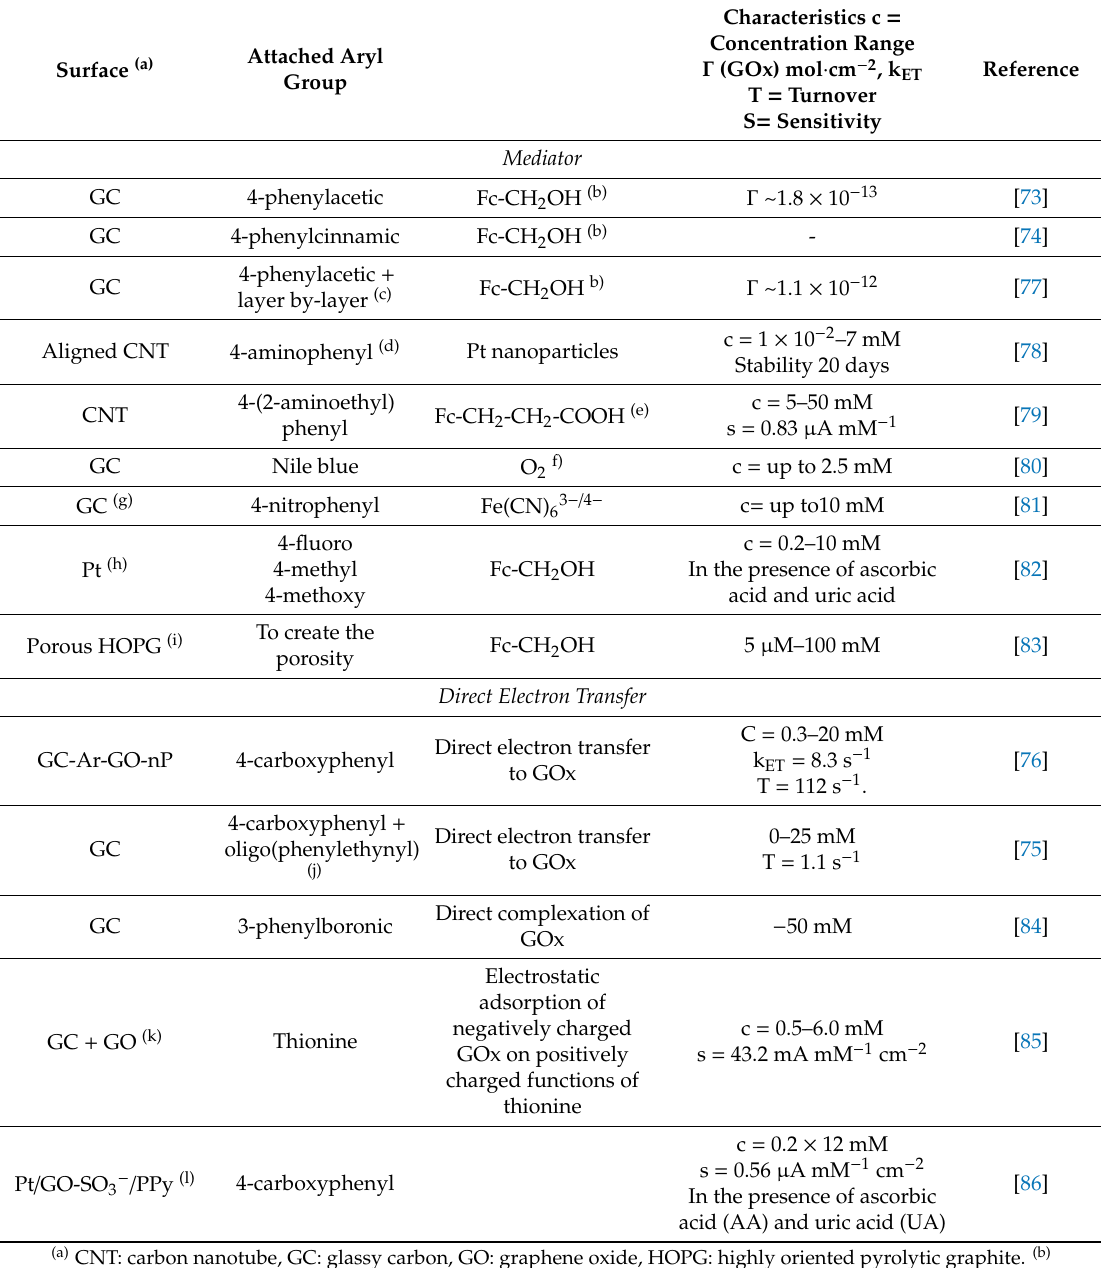
Table 2. Glucose sensors based on diazonium grafting. GOx—glucose